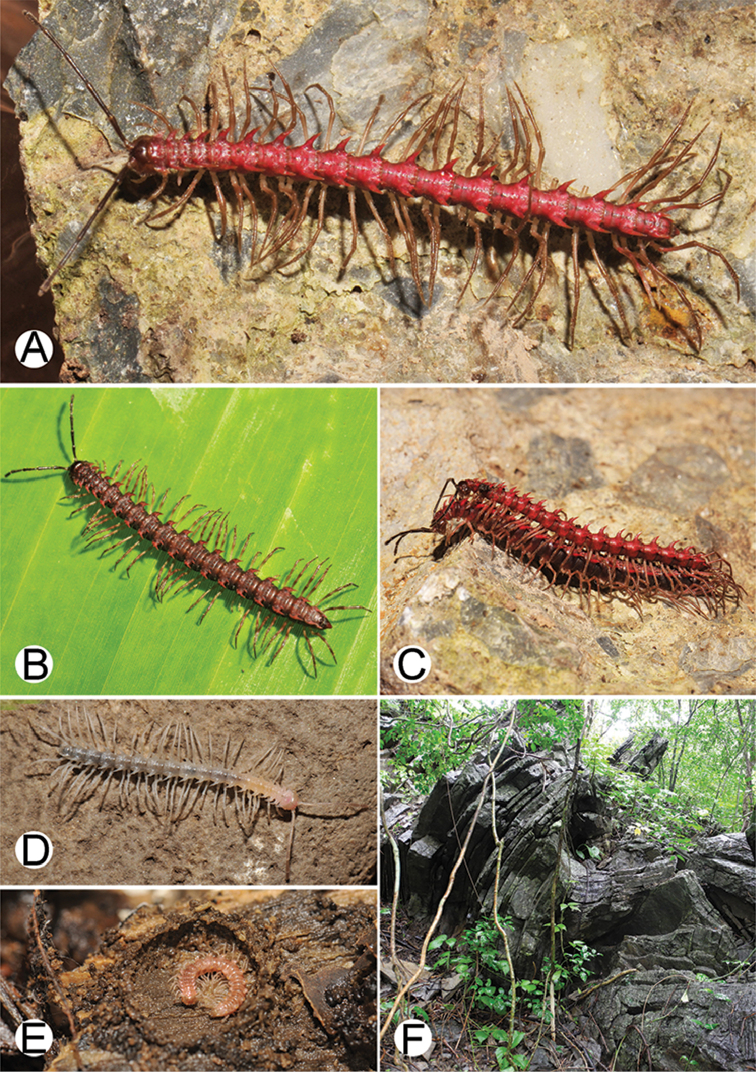

Desmoxytes
takensis Srisonchai et al., 2016 (specimen from Chao Por Phawo Shrine) and habitat. A male B female C mating couple D early adult E moulting chamber F habitat.